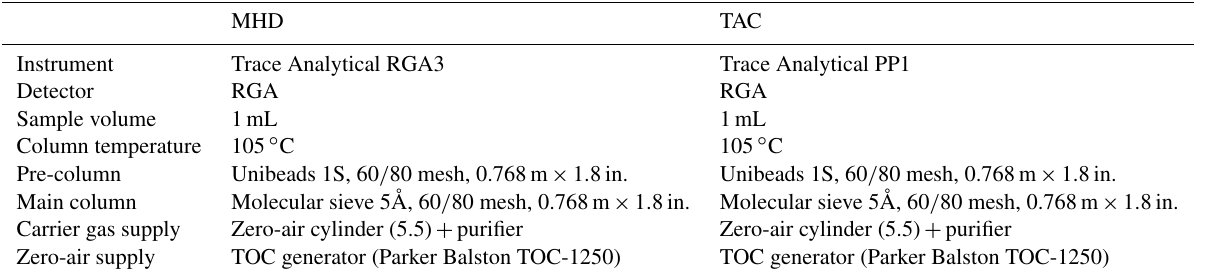
Table 4. Reduction gas analyser equipment and setup at UK DECC